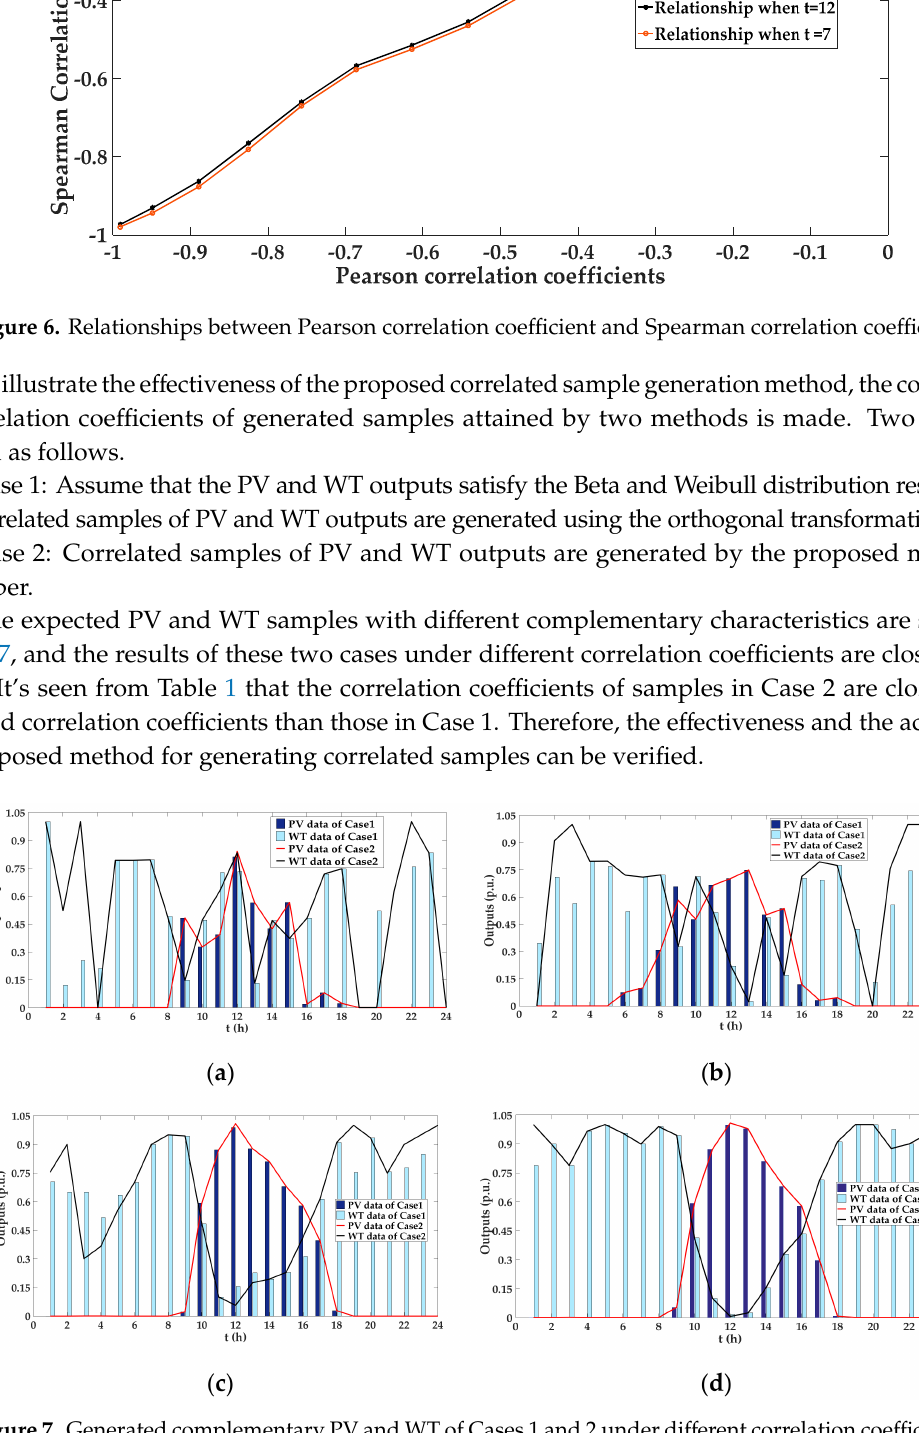
Figure 7. Generated complementary PV and WT of Cases 1 and 2 under di ff erent correlation coe ffi cients. ( a ) η = − 0.2; ( b ) η = − 0.5; ( c ) η = − 0.8; ( d ) η = −